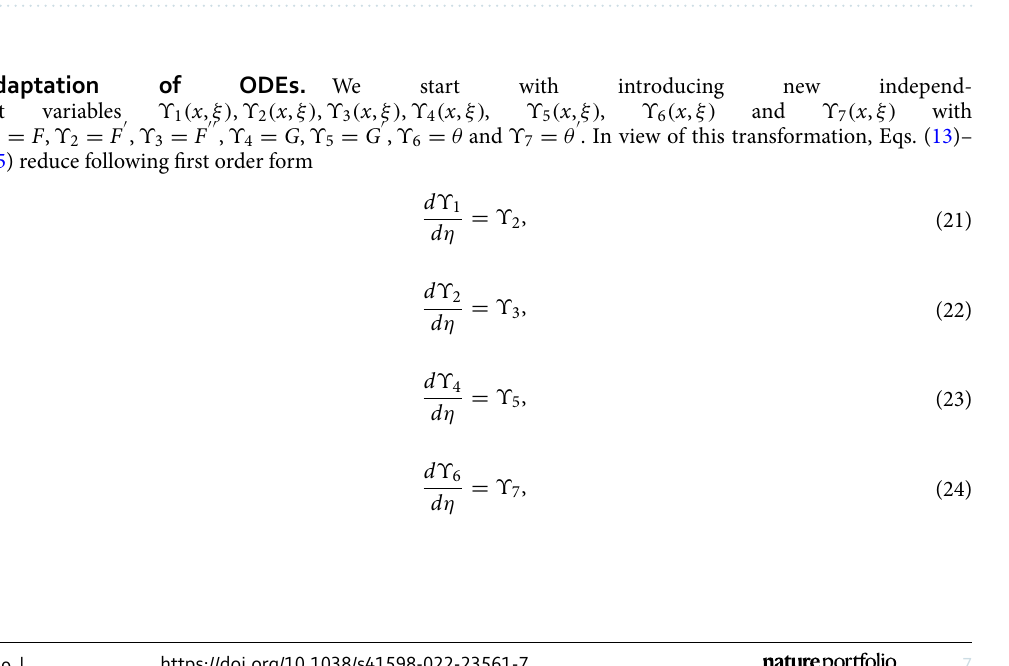
Figure 2. ( a ) Flow diagram illustrating SOC. ( b ) Characteristic grid construction for alteration